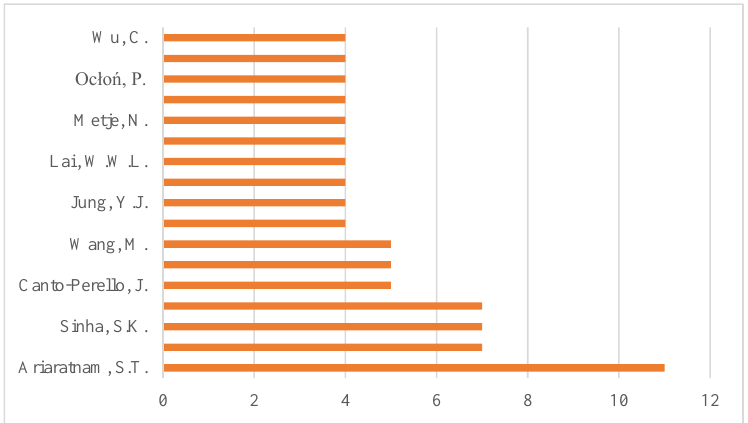
Figure 4. The number of UI-related journal papers published by different countries or regions.